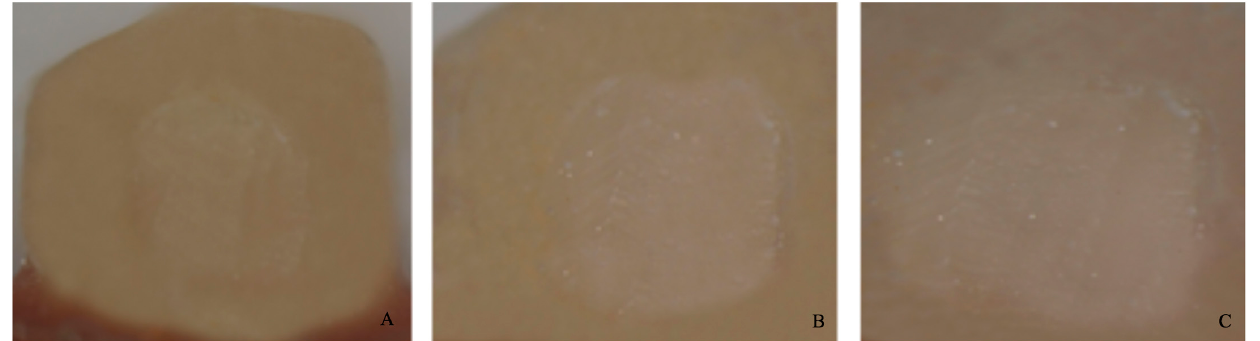
Figure 6. Score 2. ( A ) Magnification: 10 × 1; ( B ) Magnification: 10 × 1.6; ( C ) Magnification: 10 × 2.5. Figure 7. Score 3. ( A ) Magnification: 10 × 1; ( B ) Magnification: 10 × 1.6; ( C ) Magnification: 10 × 2.5. 2.3. Statistical Analysis The statistical software SPSS (Statistical Package for Social Science) for Microsoft Windows version 23.0 was used for the statistical analysis of data. The level of significance was set at 0.05 ( p ≤ 0.05). The normality of distribution of bond strength values was tested by the Shapiro–Wilk test and the homogeneity of the variance was tested using the Levene test. An analysis of variance (ANOVA) modified according to Welch was used to deter ‐ mine any significant difference in the bond strength between the seven groups. A post hoc Tukey test was used to identify which means were significantly different from each other. Two different observers evaluated the ARI index. The Chi ‐ square test and the Cramer’s V test were used to determine the statistical significance of the ARI scores. For each group, the Pearson correlation coefficient was established between the bond strength and the ARI index.